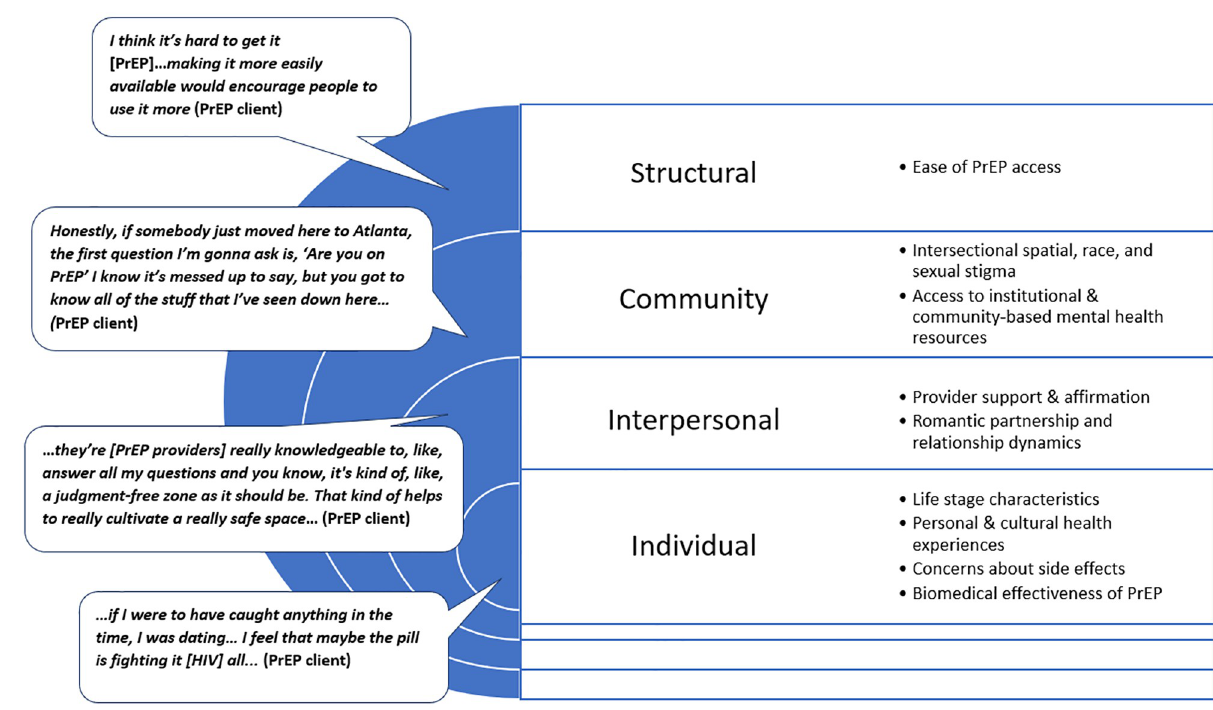
Fig 1. Socioecological model of rapid ethnographic assessment themes with exemplary quotes.